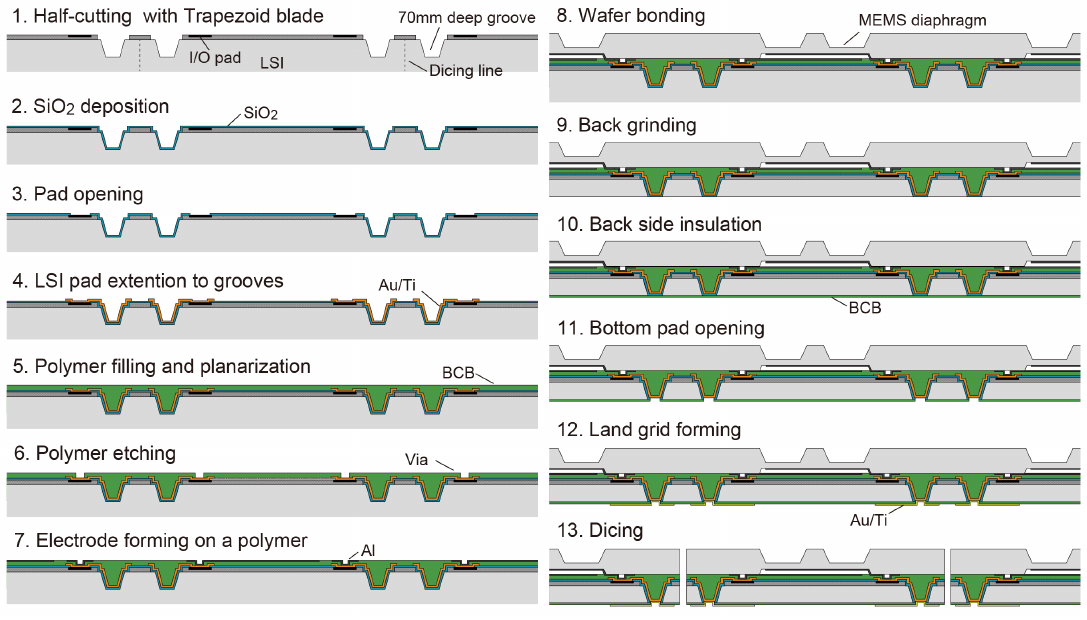
Figure 6. The full process chart of wafer level integration and packaging for tactile